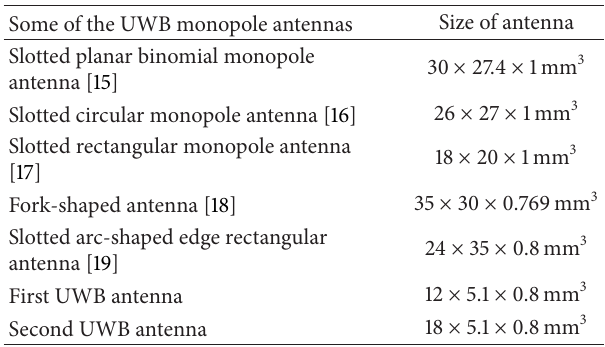
Table 1: Radiation characteristics of two compact antennas in comparison to the proposed miniature antennas.